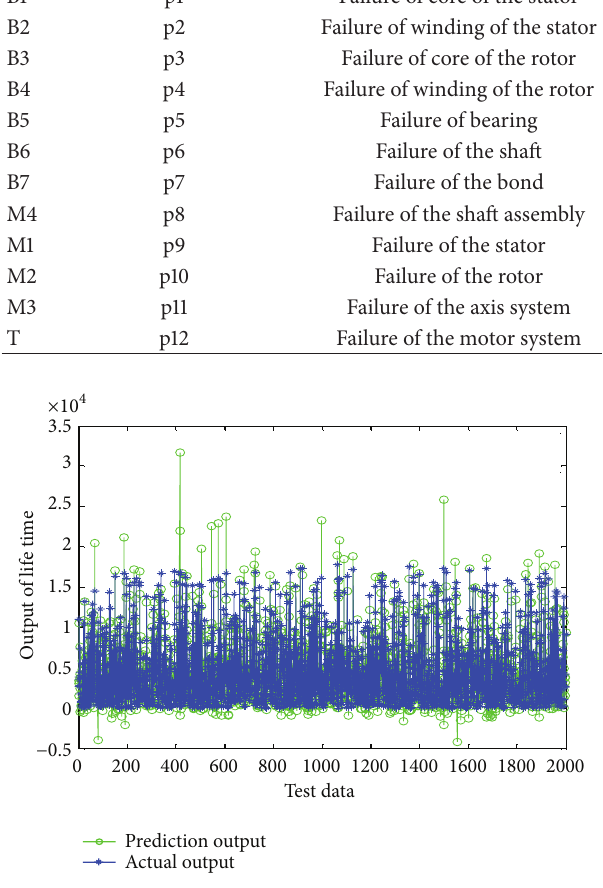
Figure 8: Prediction output of the proposed